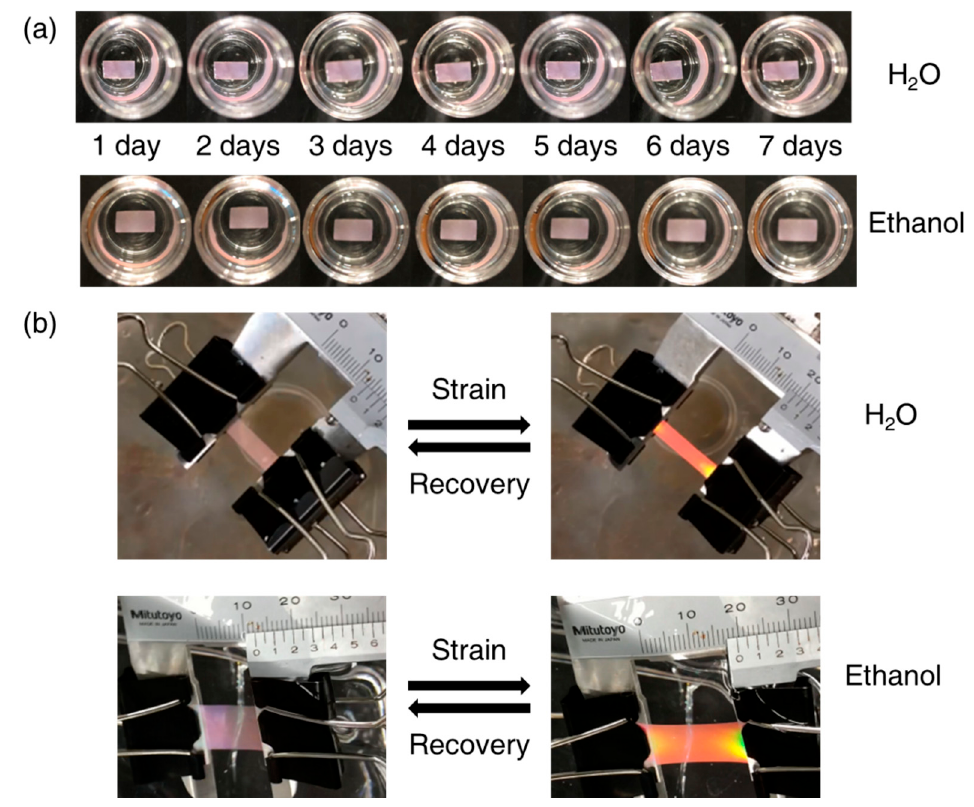
Figure 5. ( a ) N* LC (2.0) elastomer immersed in water and ethanol over 1 week, and ( b ) color change under an applied tensile strain in water and ethanol baths.